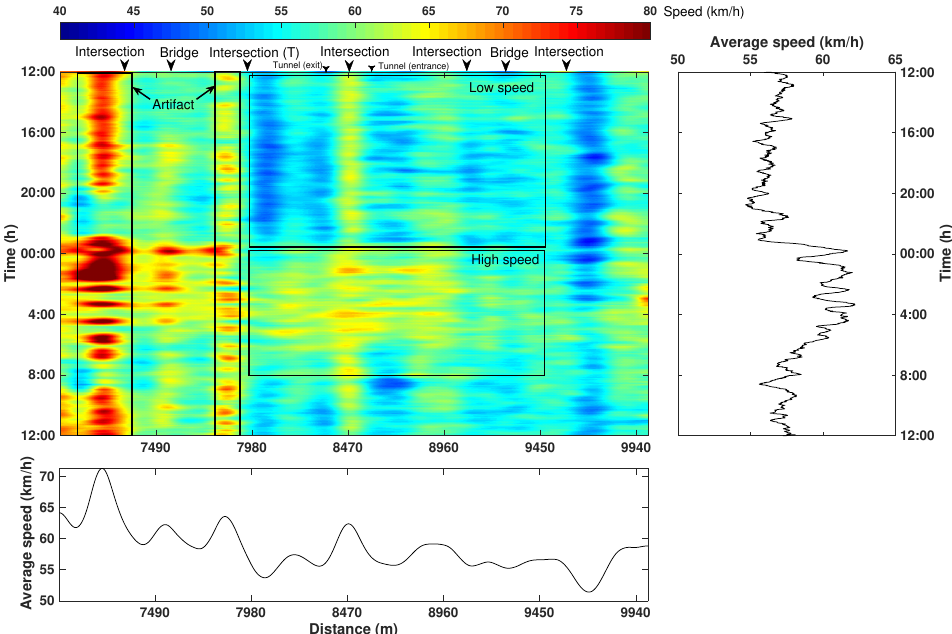
Figure 19. A 24 h spatial–temporal variation map of the speed attribute. On the right side is the averaged result along the spatial direction. On the bottom is the averaged result along the temporal